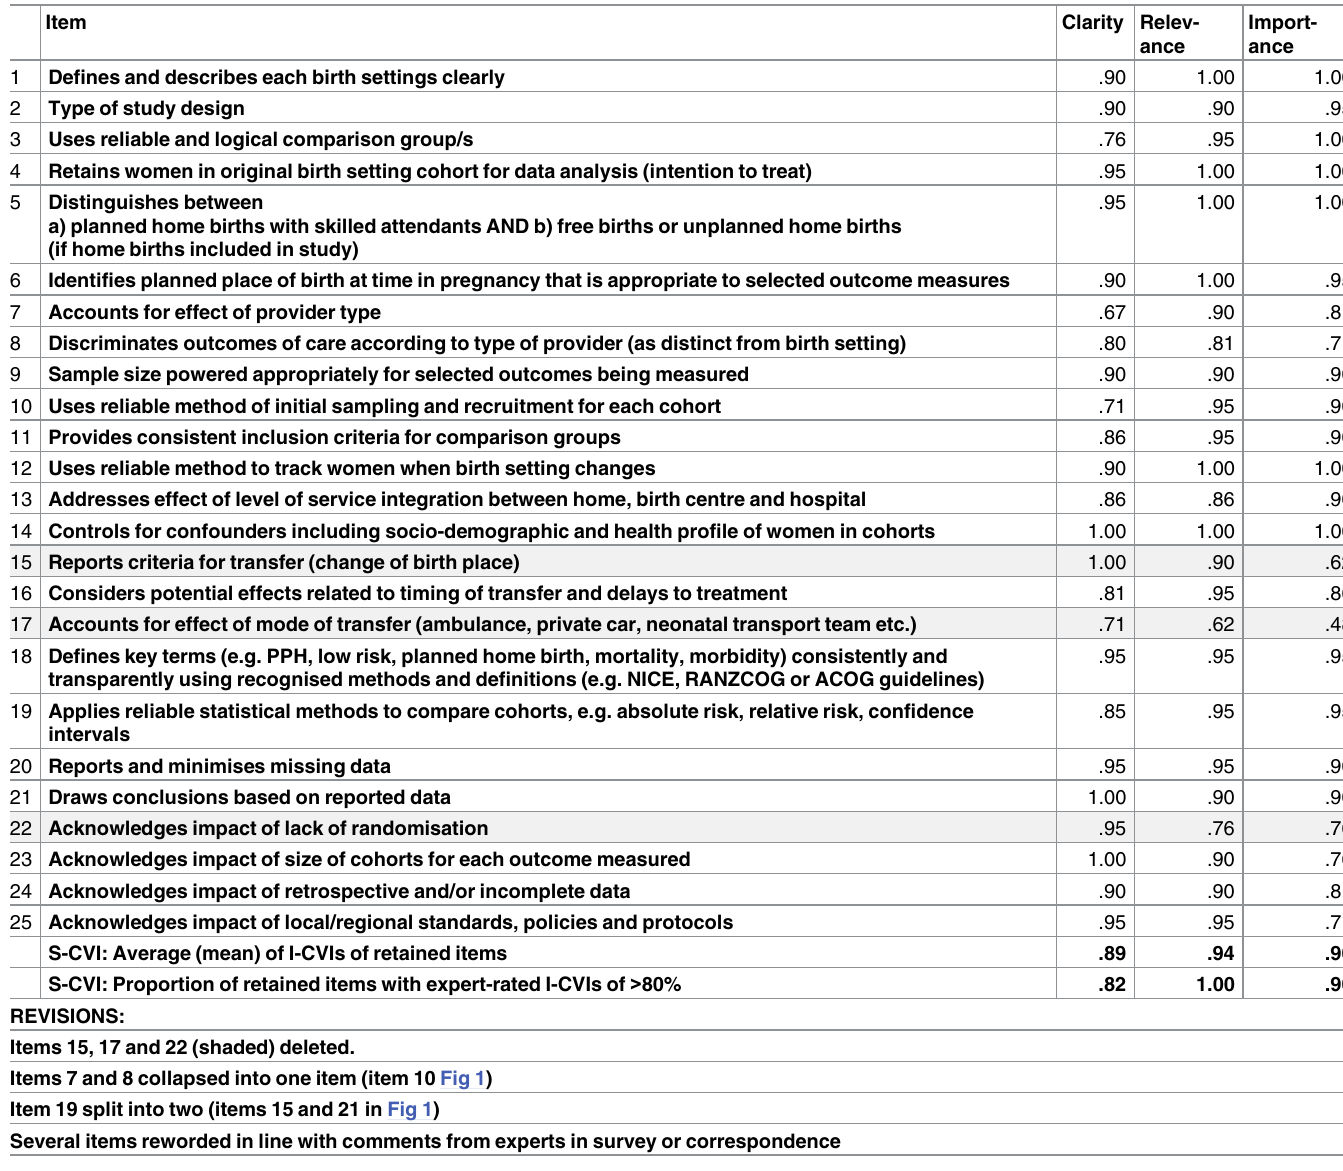
Table 1. Content validation indices–DRAFT ResQu items, proportion of expert panel giving a positive rating *